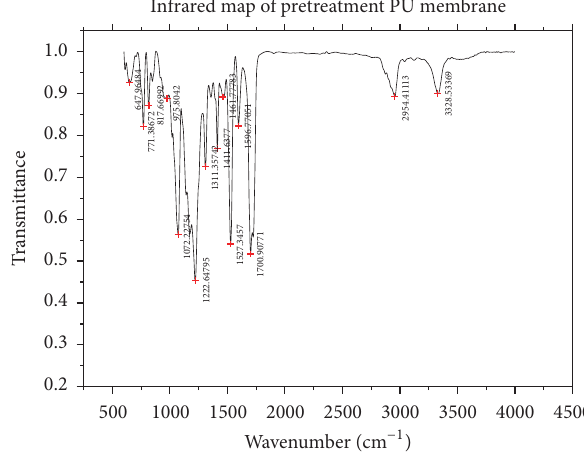
Figure 4: ATR-FTIR spectrum of pretreatment PU membrane.